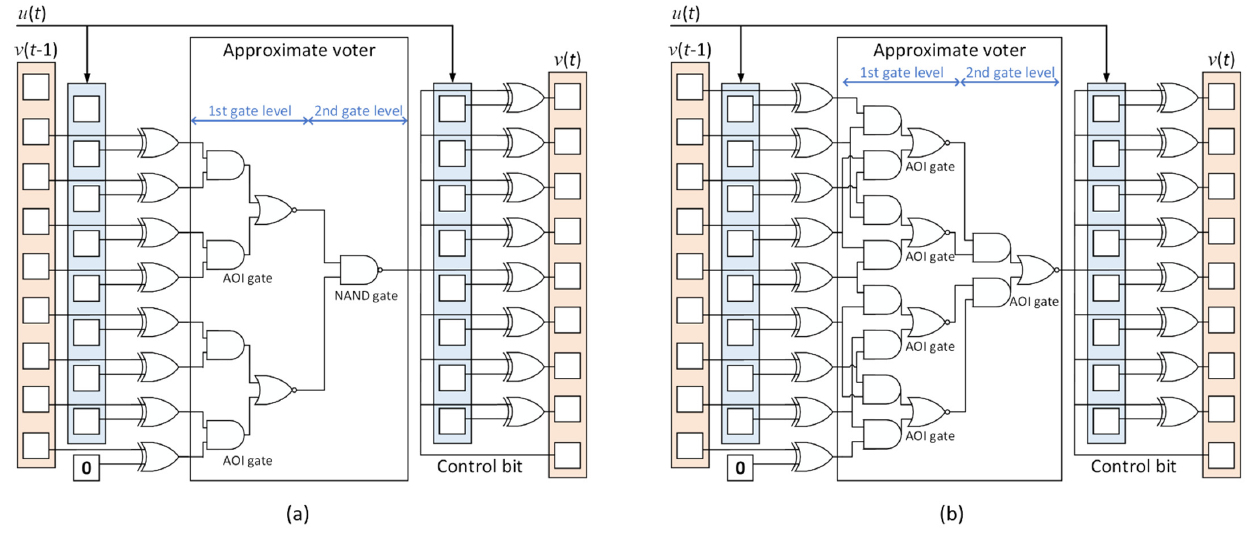
Figure 5. Two proposed DBI encoders: ( a ) AOI-NAND ENC and ( b ) AOI-AOI ENC.